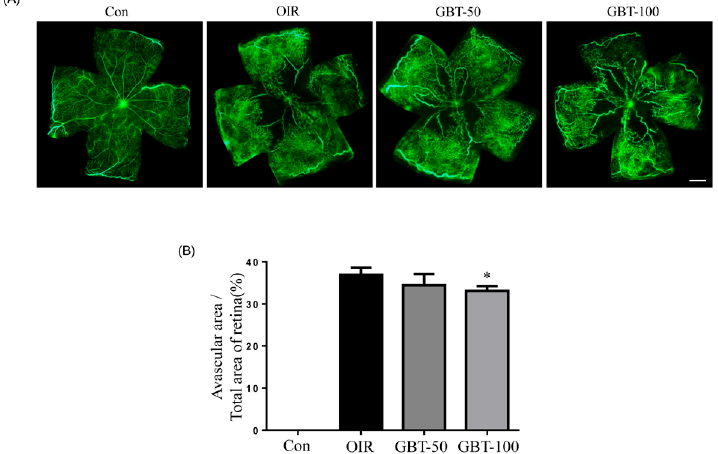
Figure 1. The effect of GBT on retinal neovascularization in OIR mice. ( A ) The retinal blood vessels were visualized via fluorescein angiography using FITC-dextran. Con, normal control mice; OIR, saline-treated OIR mice; GBT-50, OIR mice treated with 50 mg/kg of GBT; and GBT-100, OIR mice treated with 100 mg/kg GBT; Scale bar = 500 µm; ( B ) The quantification results are expressed as a percentage of the central nonperfused area within the total retinal area. The bar graph values represent the mean ± SE ( n = 5). * p < 0.05 for OIR group vs. GBT-treated group. Morphometric analysis of retinal flat mounts stained with TRITC–isolectin B4 was conducted to assess vessel growth (Figure 2). GBT treatment prevented pathogenic retinal neovascularization